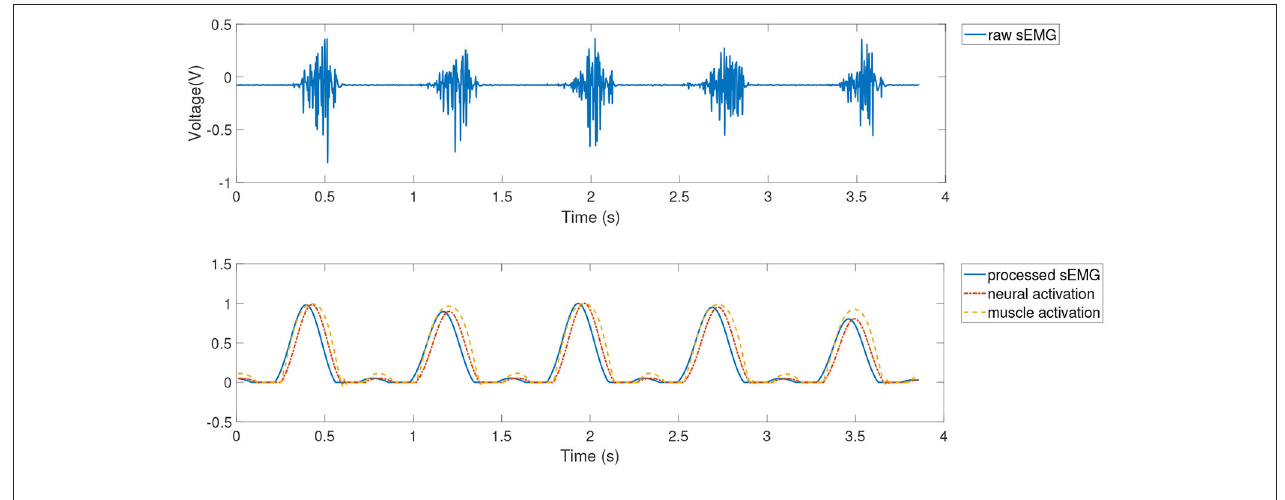
FIGURE 4 | Feature extraction of the lateral femoral.